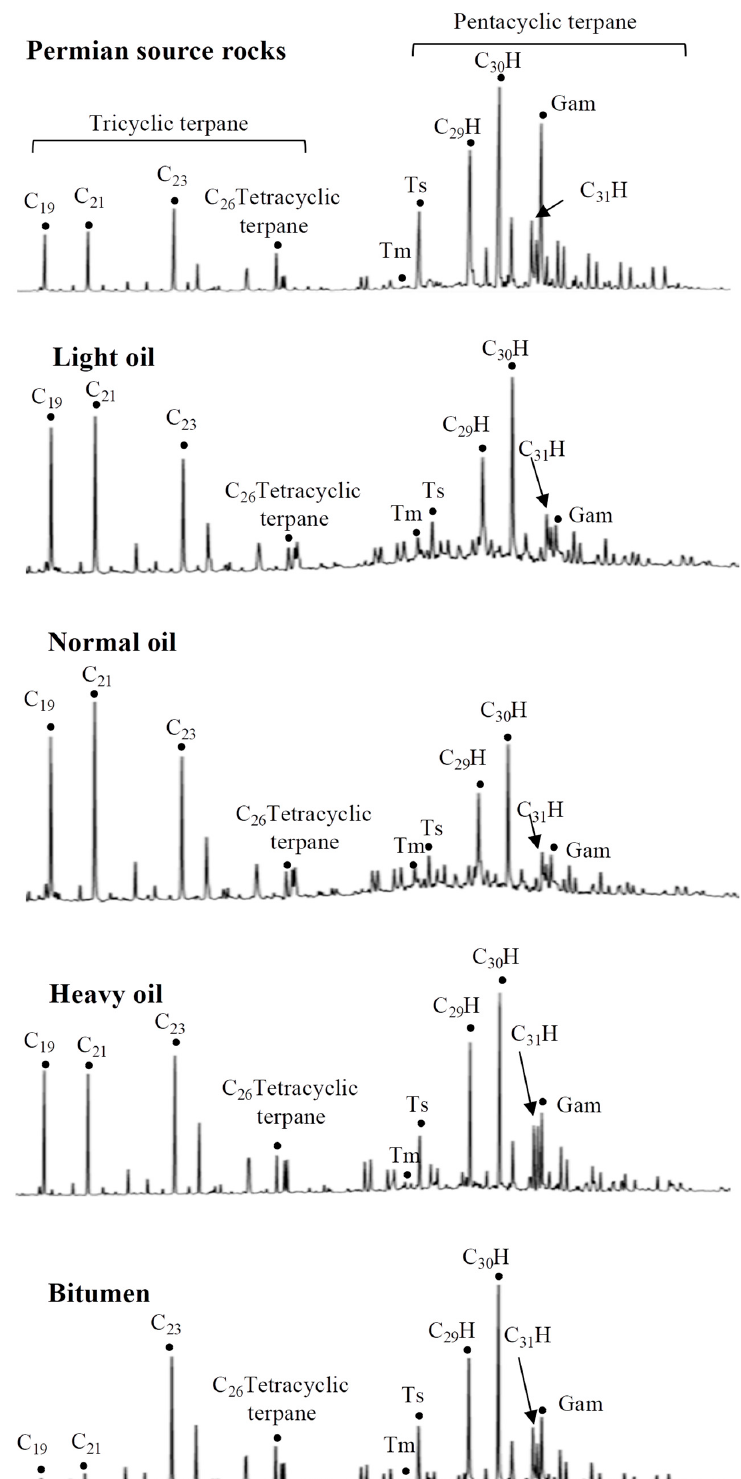
Figure 8. Mass chromatogram of hopanes of source rocks and crude oil samples in Wuerhe area, showing the C 19 , C 21 , and C 23 peaks of tricyclic terpanes are higher than those of the rest; the Ts peaks are higher than the Tm peaks, and the peaks of C 30 -C 35 hopanes decrease in turn and contain high gammacerane alkanes.